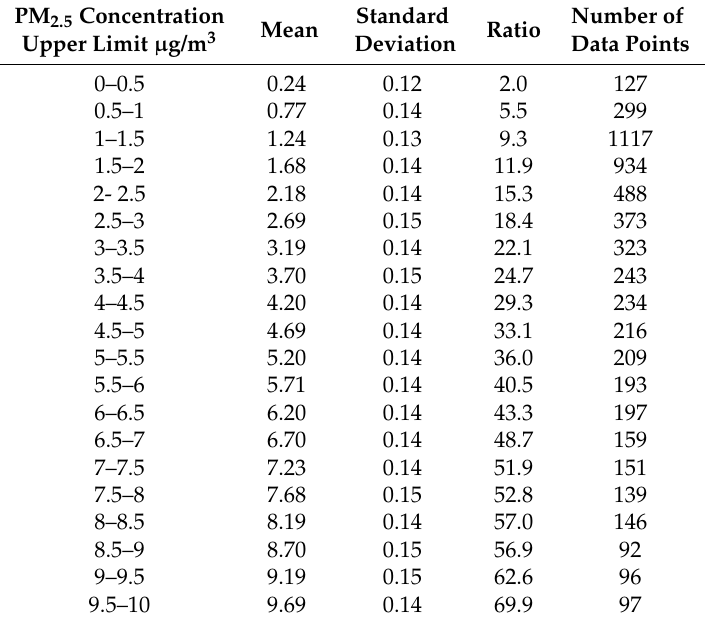
Table A3. PM 2.5 concentration range, the mean and the standard deviation of the PM 2.5 concentrations within that range, the ration of the mean and the standard deviation and the number of data points used for the calculations for Alphasense OPC-R1. The Lower limit of detection with Wallace et al. [65] method is defined as the PM 2.5 concentration above which the ratio is >